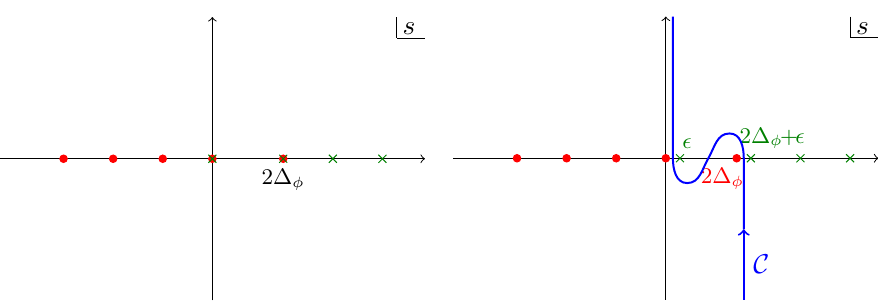
Figure 2 . Left : the configuration of the poles for GFF. The left and right poles coincide in s = 0 and s = 2∆ . Right : the right poles are slightly shifted to the right so that the contour C can run φ in the